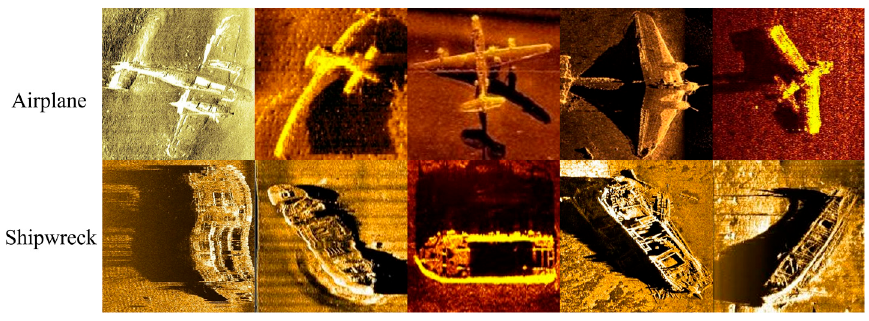
Figure 14. Examples of real sonar images.